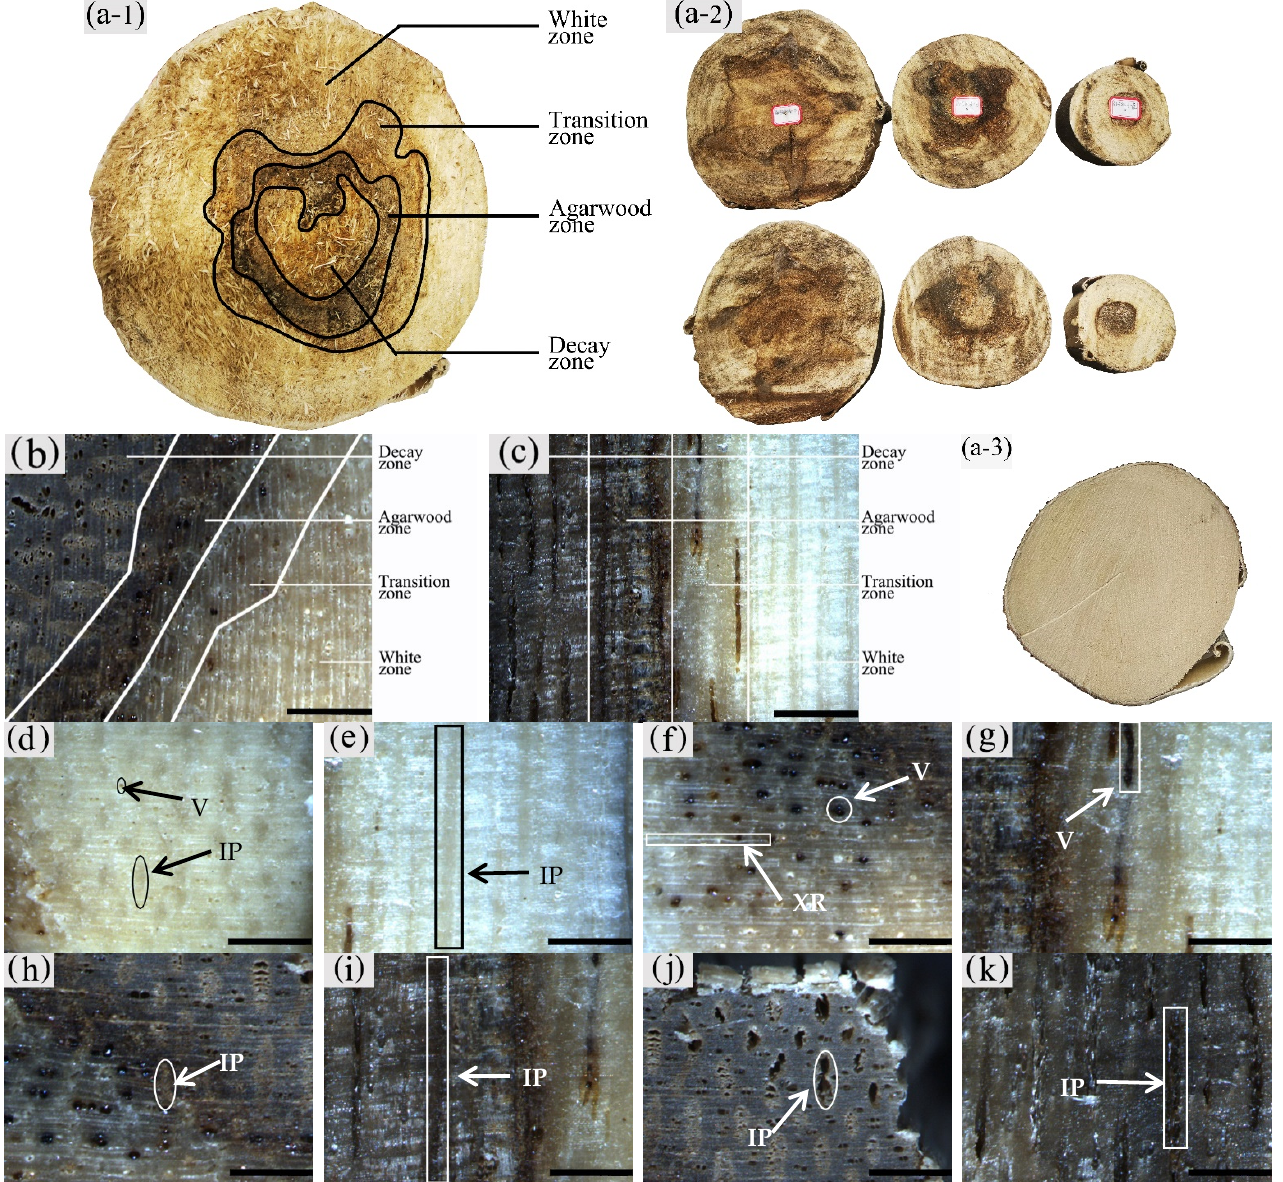
Figure 3. Macrostructure of the xylem of A. sinensis . ( a-1, a-2 ) Different zones of air-dried timber in transverse surface. ( a-3 ) blank control without being inoculated. ( b ) Different zones in transverse surface. ( c ) Different zones in radial surface. ( d ) Transverse surface of white zone. ( e ) Radial surface of white zone. ( f ) Transverse surface of transition zone. ( g ) Radial surface of transition zone. ( h ) The dark part is the transverse surface of agarwood zone. ( i ) The dark part is the radial surface of agarwood zone. ( j ) Transverse surface of decay zone. ( k ) Radial surface of decay zone. V: vessel; IP: interxylary phloem; XR: xylem ray. Scale bars = ( a ) 100 mm; ( b – k ) 400 µ m. The macroscopic structure of the xylem of A. sinensis inoculated for 12 and 18 months differed. In terms of zoning characteristics, the decay zone of A. sinensis with 12 months